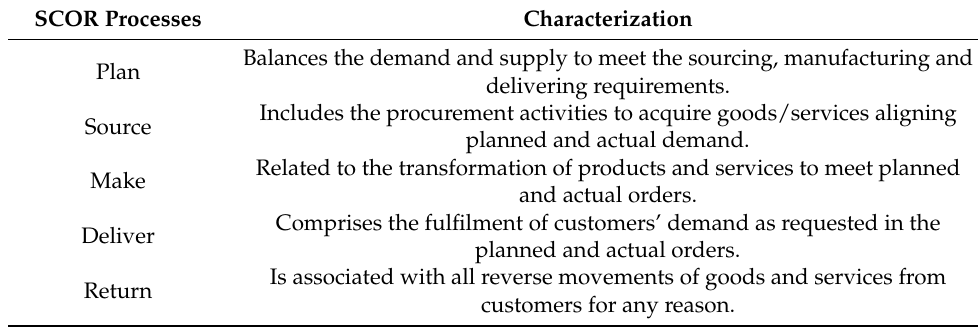
Table 1. Main Processes of supply chain operations reference (SCOR) Model [34]. SCOR Processes